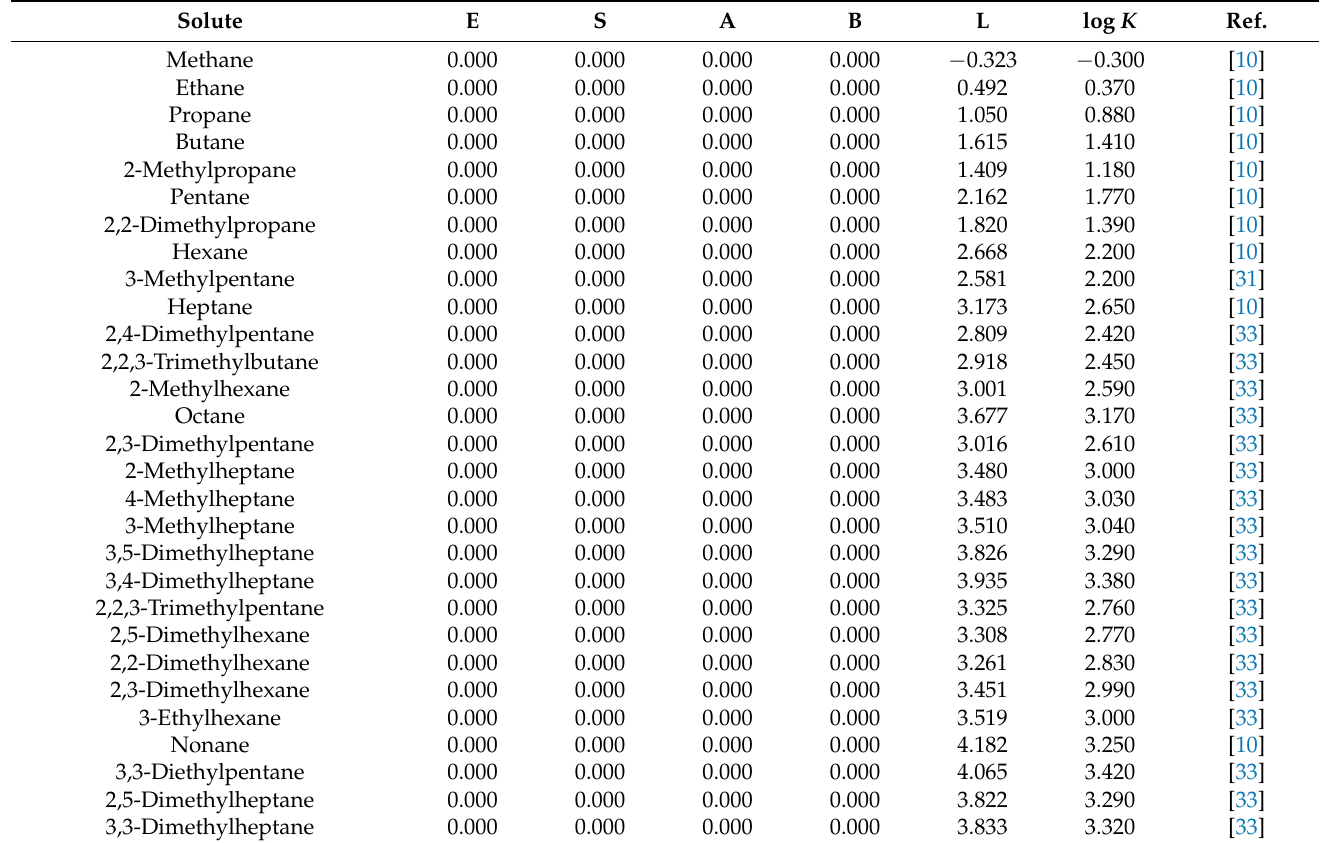
Table 2. Experimental gas-to-polydimethylsiloxane partition coefficient, log K PDMS-gas (wet + dry), measured near 298 K, along with the Abraham model solute descriptors of compounds considered in the current